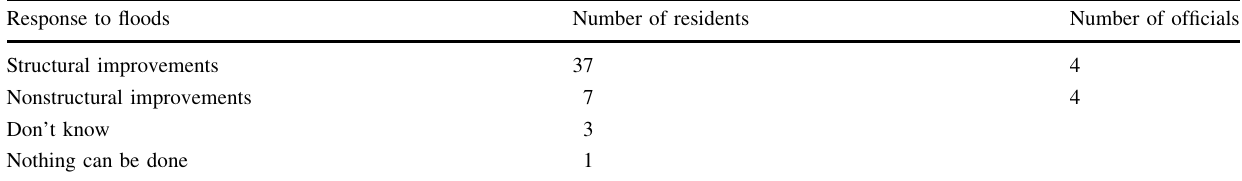
Table 8 Distribution of answers from local residents and public officials regarding suggestions for improvements in the Akuressa area of Sri Lanka Response to